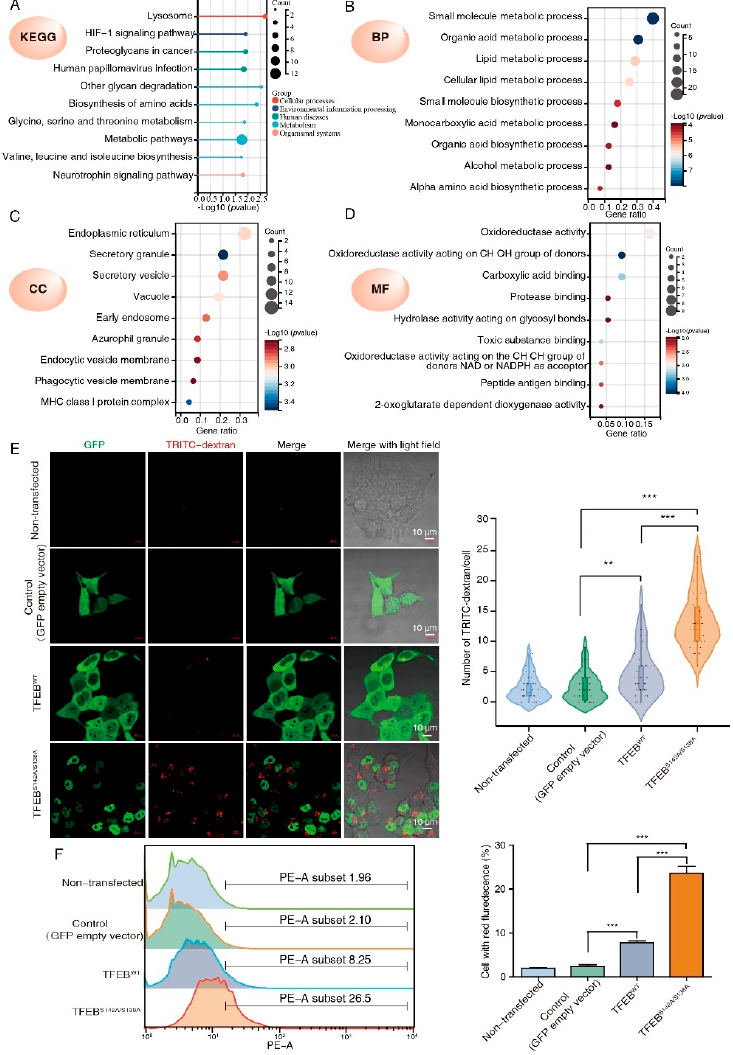
Figure 3. GO classification and pathway analysis of the TFEB transcriptional regulated proteins. ( A ) KEGG analysis of the 60 TFEB transcriptional regulated proteins. ( B – D ) The same proteins were subjected to the GO analysis (BP, biological process; CC, cellular component; MF, molecular function). ( E , F ) DLD1 cells stably expressing TFEB WT or TFEB S142A/S138A were incubated with TRITC-dextran (0.2 mg/mL) in a growth medium at 37 ◦ C for 2 h. The representative confocal images show internalized TRITC-dextran (red dots) in indicated cells. Scale bars, 10 µ m. Quantification is indicated on the right. Mean ± SD, n = 30 cells per condition, unpaired t -test. ( E ) Pinocytosis quantification using TRITC-dextran in indicated cells by flow cytometry. ( F ) Mean ± SEM, n = 3, unpaired t -test. ** p < 0.001, *** p <